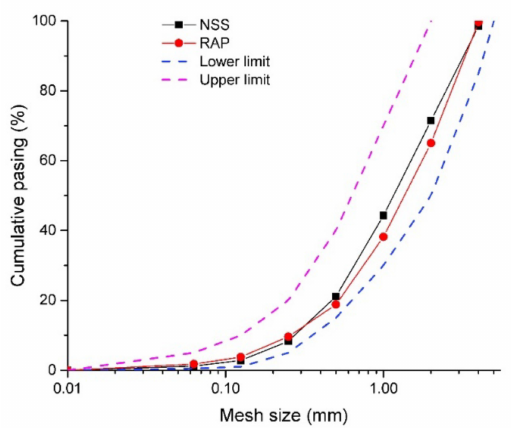
Figure 2. Particle size distribution of silica sand and RAP.